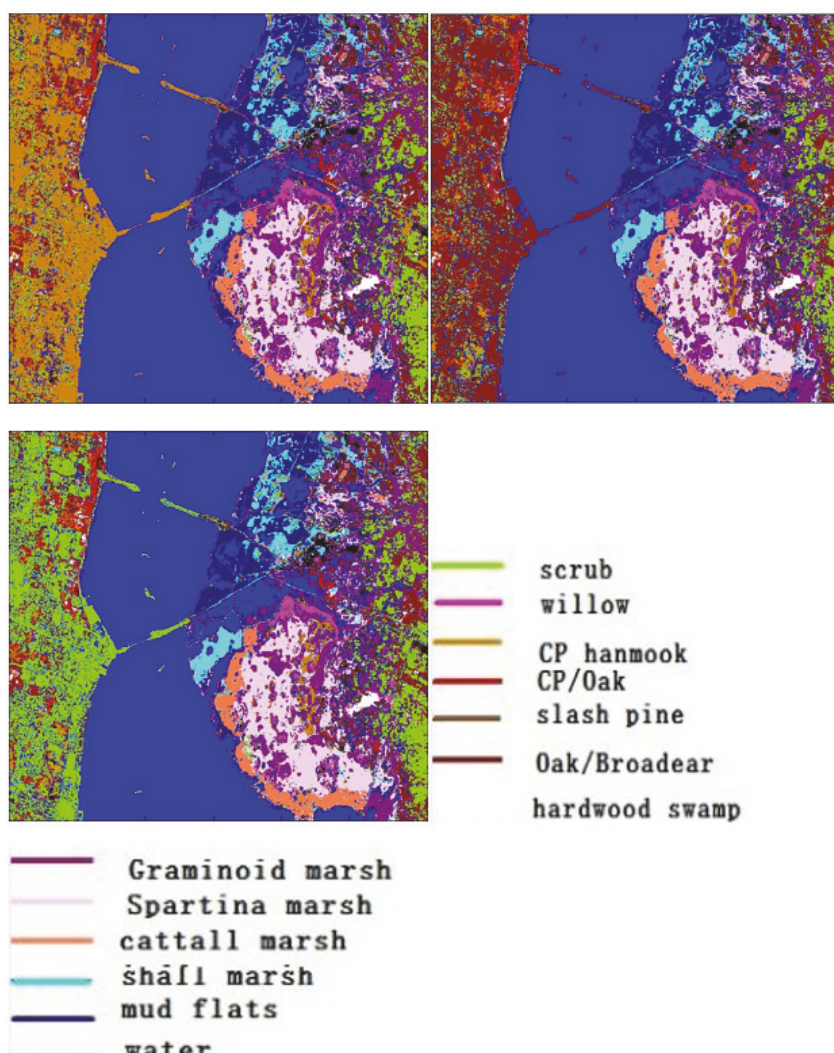
Figure 18: The classification results in the initial 10% label conditions of the algorithm for AVIRIS data.